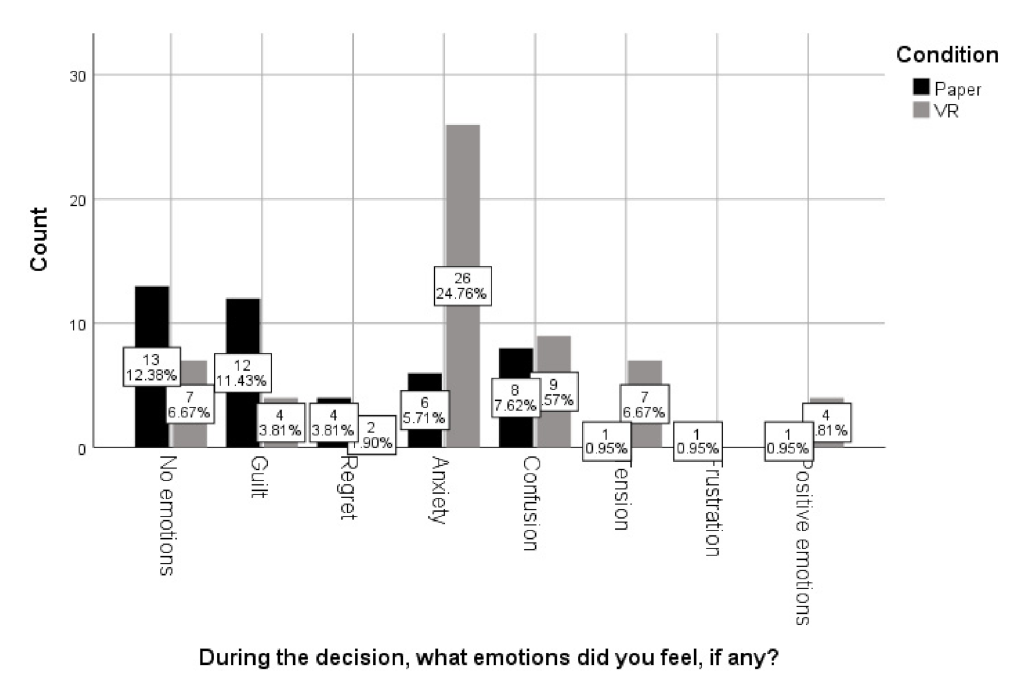
Figure 2. Differences in VR and paper version in moral reasoning (why did you make this